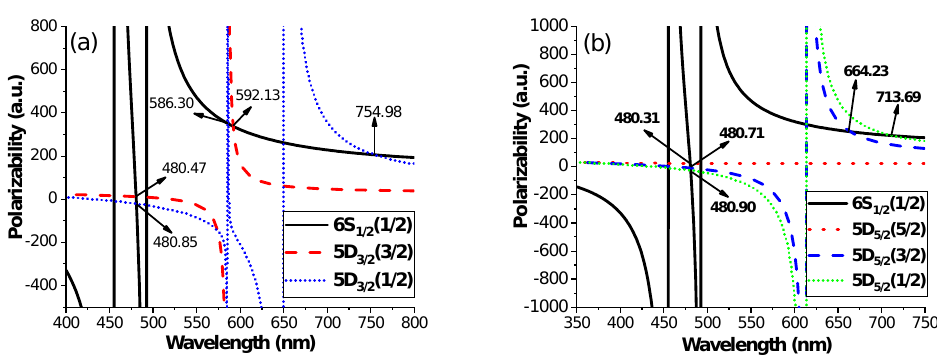
Figure 3. Variations in the polarizabilities (single-photon) with wavelength for the transitions among ( a ) 6 2 S 1 and 5 2 D 3 and ( b ) 6 2 S 1 and 5 2 D 5 states are plotted to extract the magic wavelengths 2 2 2 2 (indicated in the panels in the unit of nm) in the presence of a linearly polarized light source. Here, in ) levels of the state n 2 L the inset, the different ( J v , M J J v are indicated by nL J v v